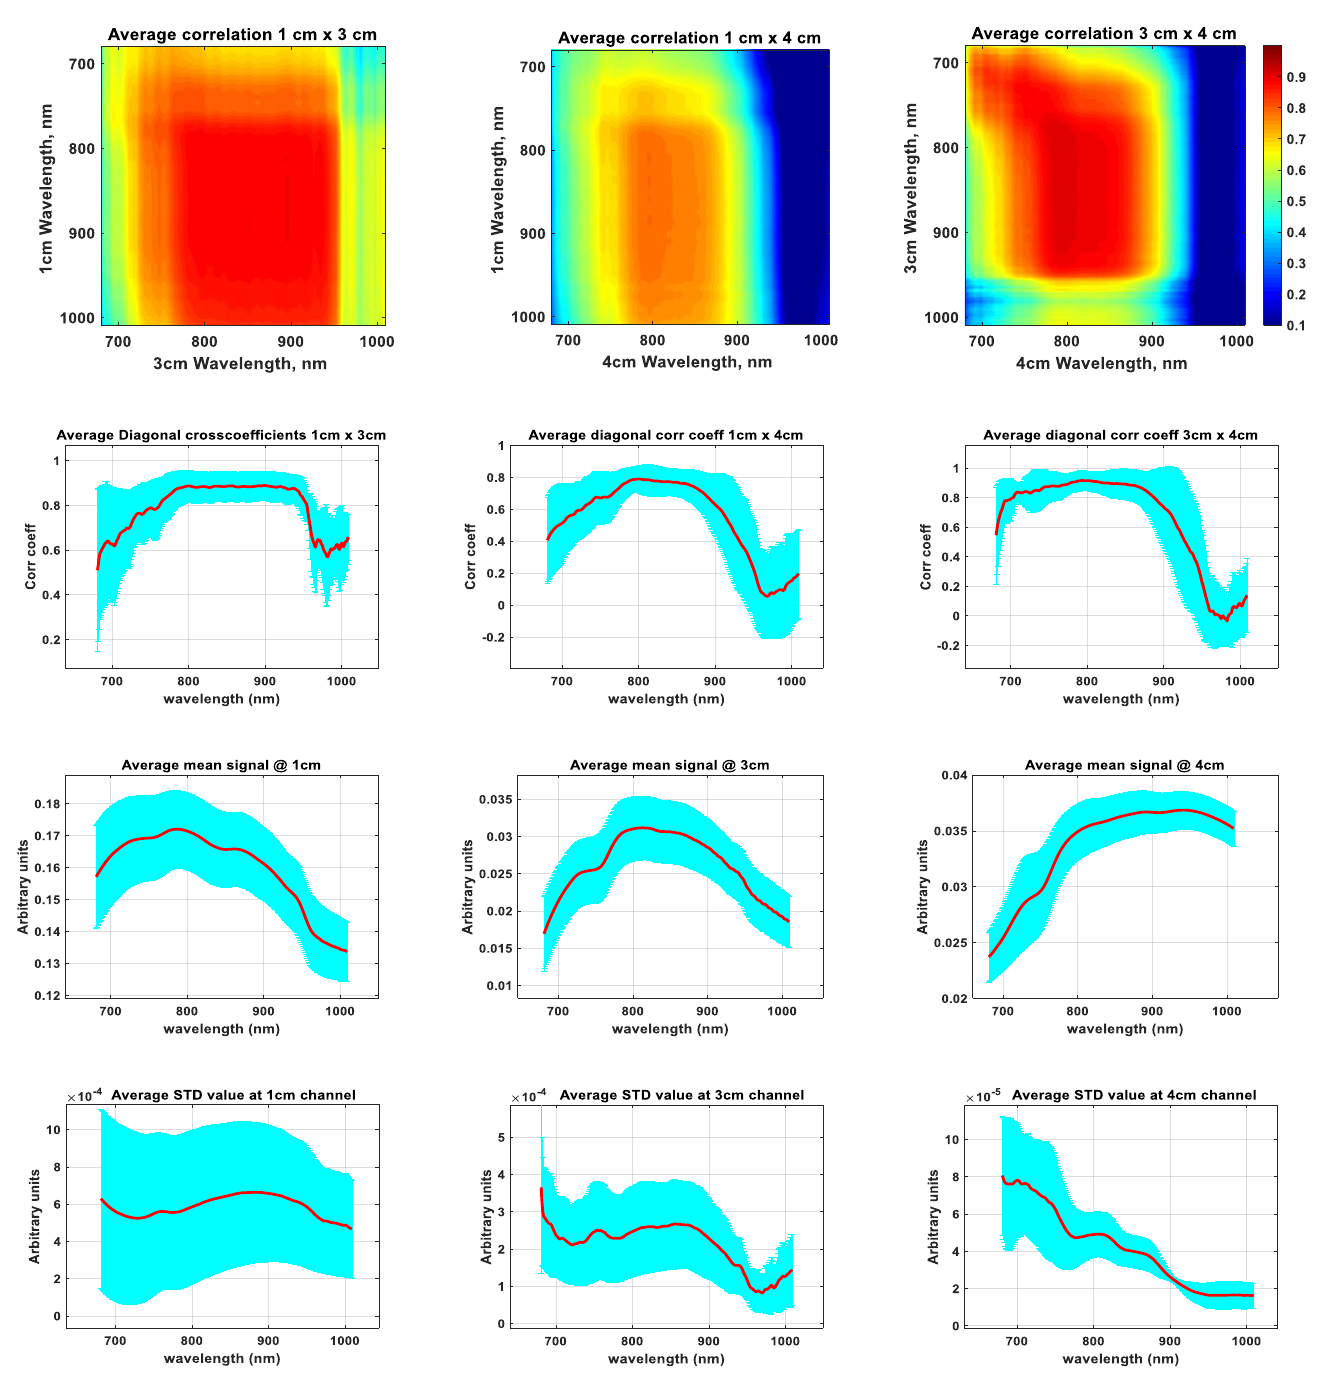
Figure 3. Hyperspectral signal analysis: cross-subject averaged correlation, temporal means, and temporal standard deviations for signals from 1 cm, 3 cm, and 4 cm channels. Blue color shows the cross-subject standard deviations.